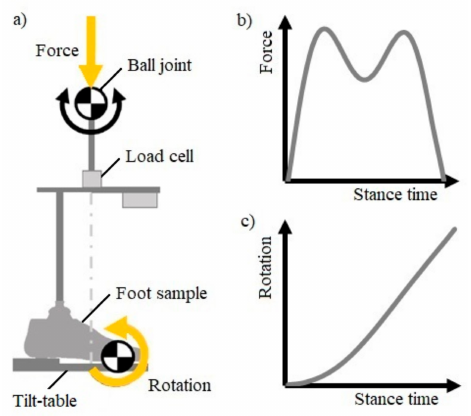
Figure 2. ( a ) Schematic image of the setup in mechanical testing according to ISO / TS 16955. Control functions, ( b ) vertical force on ball joint, and ( c ) rotation of tilt-table, as functions of stance phase time (yellow arrows in ( a )). These are applied as boundary conditions in the FE